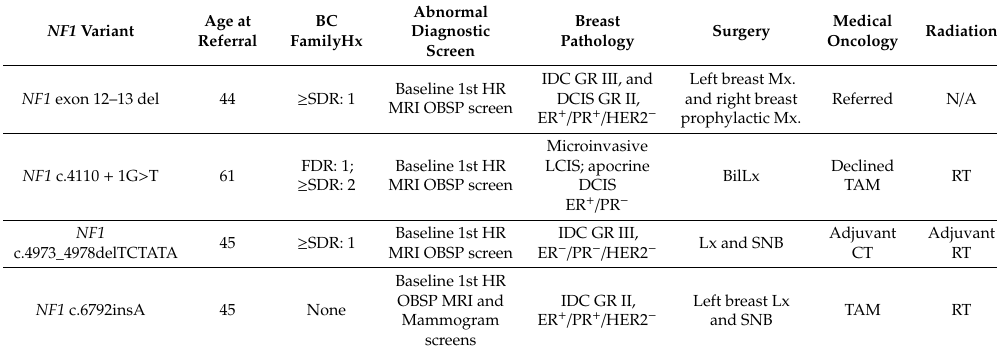
Table 3. Identified breast cancer cases in women with confirmed pathogenic variants in NF1